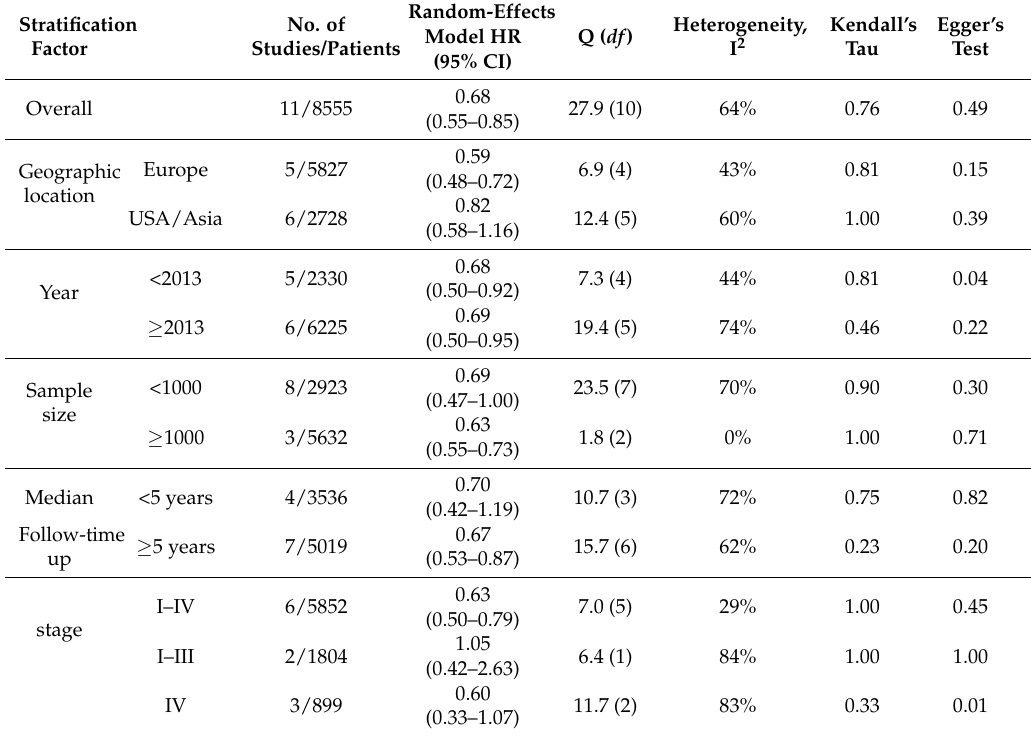
Table 2. Stratification analyses of the association between 25(OH)D concentrations (High vs. low) and overall survival in CRC